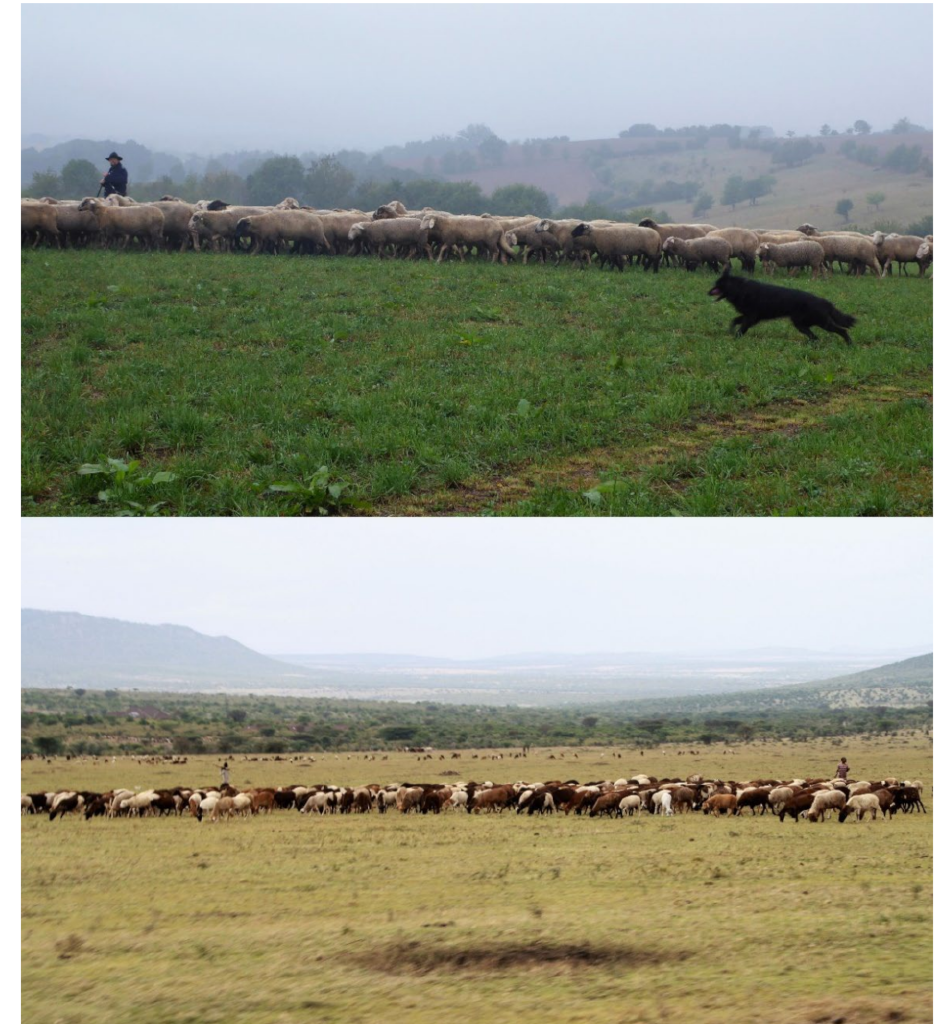
Figure 3. Herding small livestock (sheep and goats) is labor and time intensive but also a very effective method of minimizing carnivore–livestock conflicts. Bottom picture: cattle herdsmen in East Africa, top picture: shepherd in Germany. While this type of livestock husbandry practice was widespread in Central Europe in the past, it has increasingly fallen into oblivion in the course of intensified agriculture and is practiced almost exclusively in the context of nature conservation activities (musealization). It is still applied on the African continent, although it is also subject to change there [61]. Supra-regional considerations can help to transfer the experiences and knowledge of the nomads of East Africa to the situation in Central Europe, recolonized by various large carnivore species. Photo top: Christel Simantke, photo bottom: T.